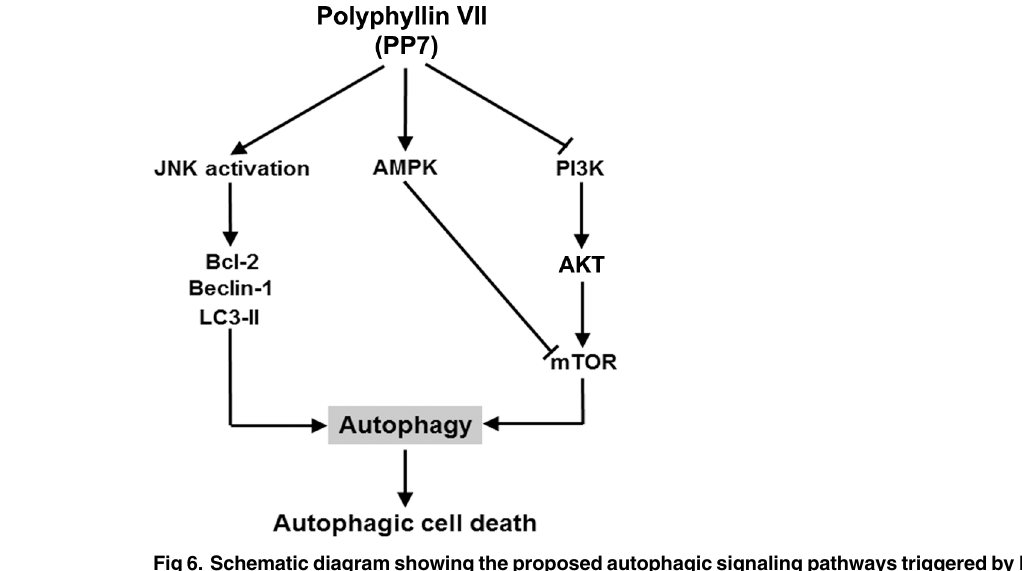
(DOC) S3 Fig. ESIMS spectrum of Polyphyllin VII. (DOC)